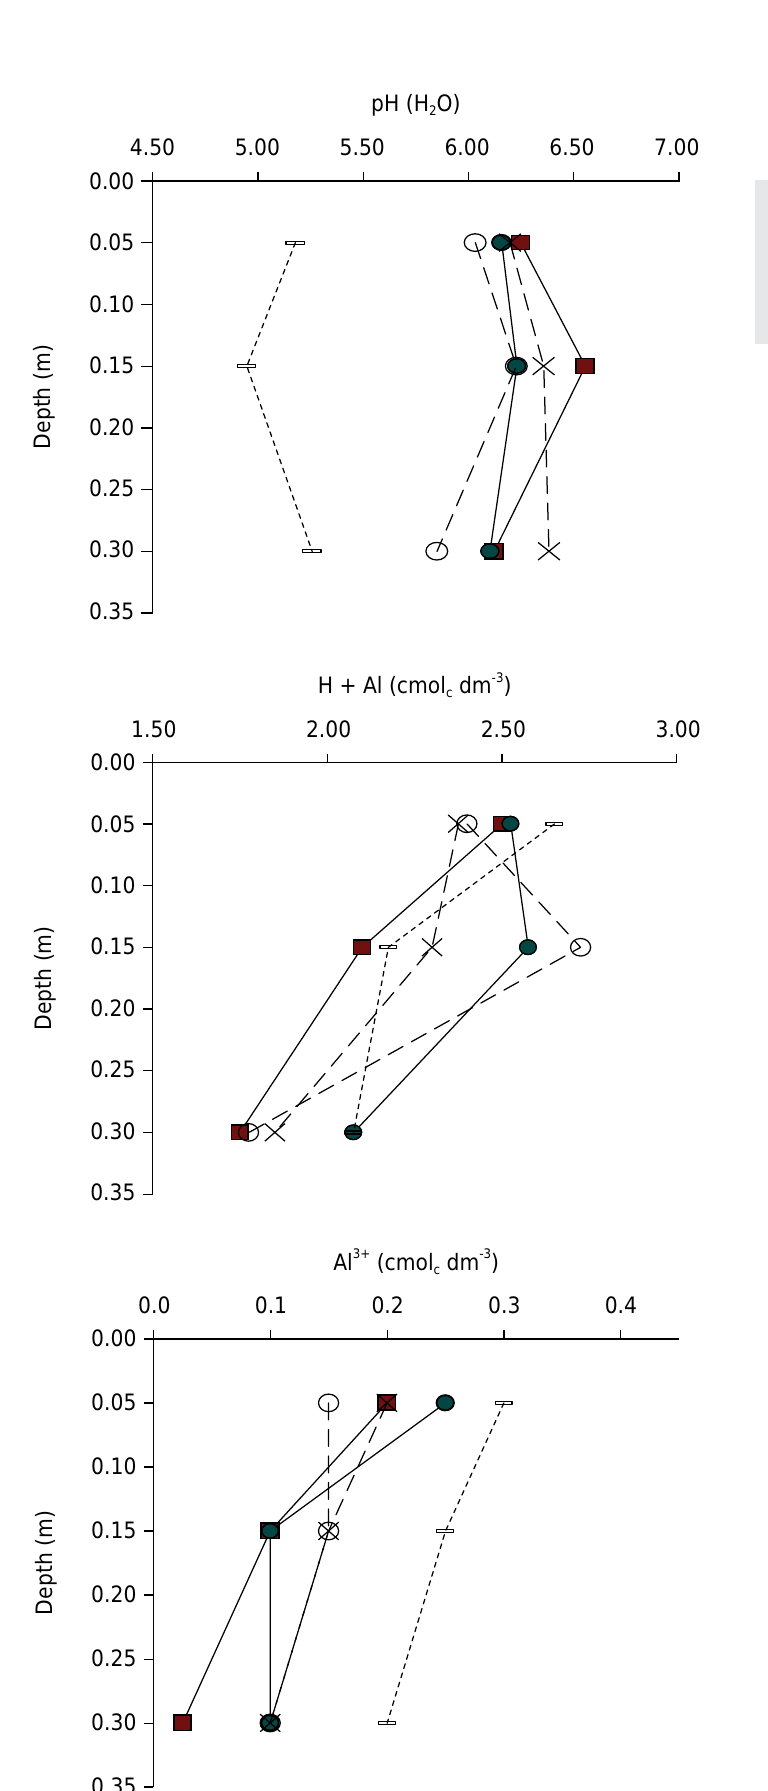
Figure 1. Average values of soil pH in water, potential acidity (H+Al) and exchangeable aluminum (Al 3+ ) in the 0.00-0.10, 0.10-0.20, and 0.20-0.40 m layers after the